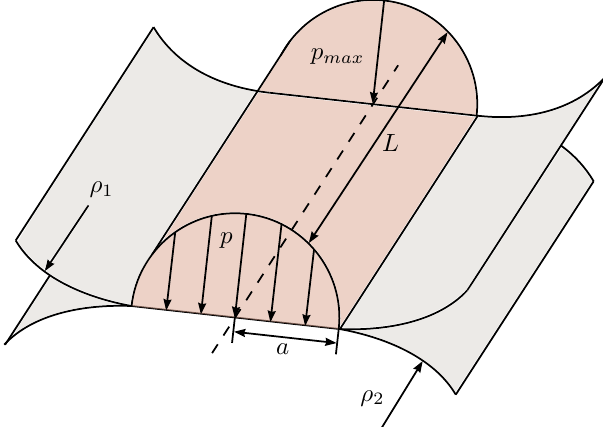
Figure 10: Hertzian pressure distribution with cylindri- cal contact using radii ρ 1 and ρ 2